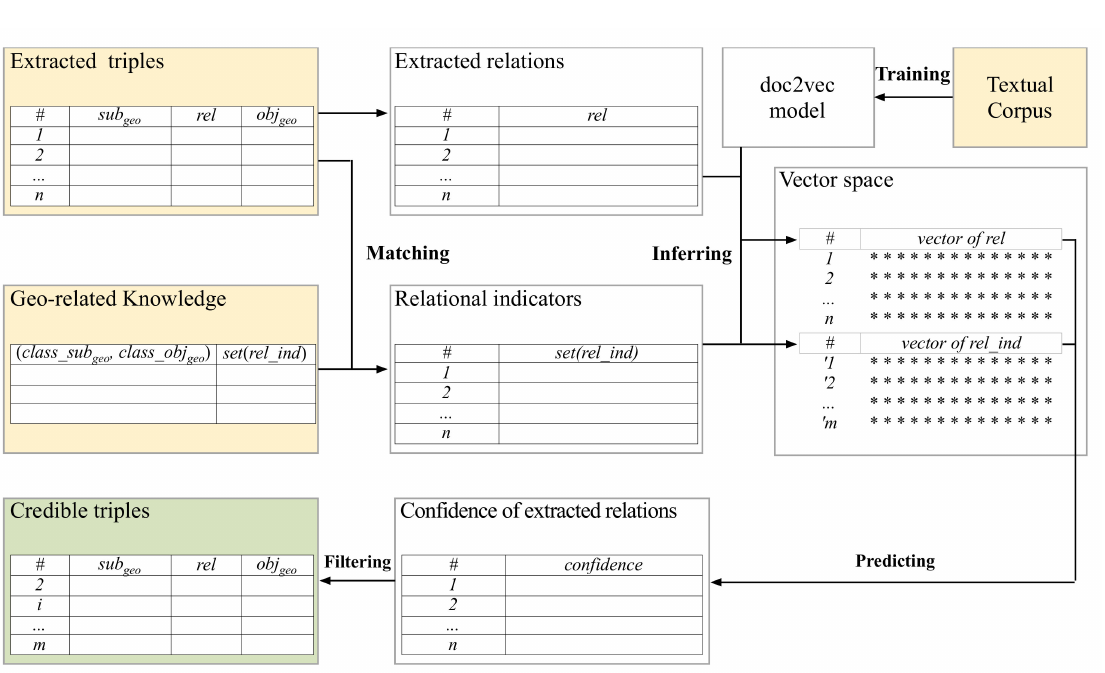
Figure 2. Flowchart of confidence prediction of geo-entity